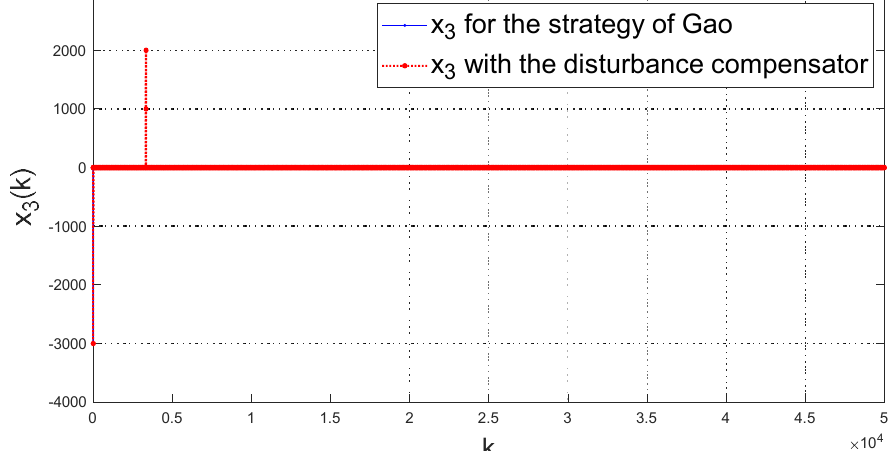
16 of 19 Figure 10. x 2 ( k ) for both control strategies in the sliding phase.